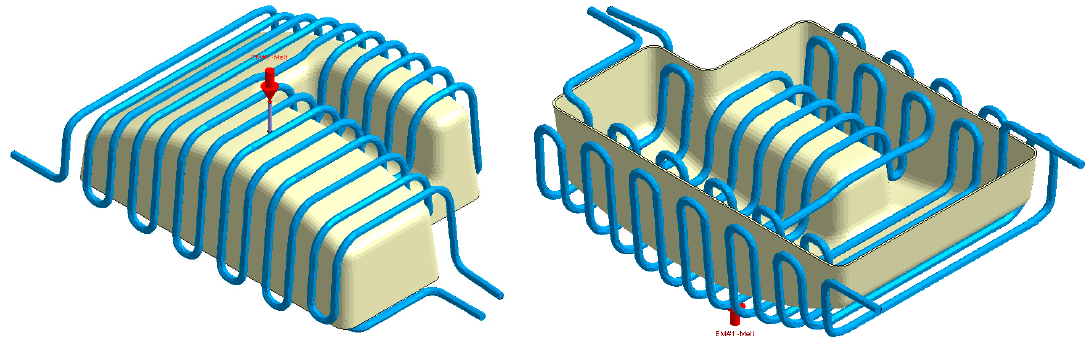
Figure 33. Cooling system design, Case D. Front view ( left ) and bottom view ( right ).